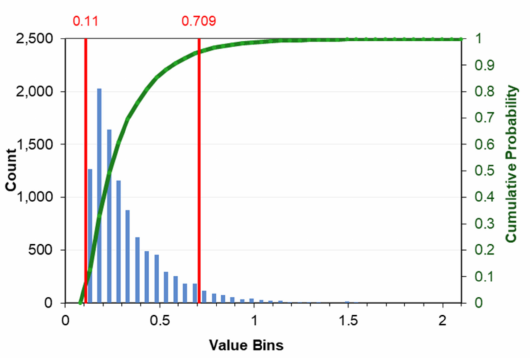
Figure 15. Histogram of Simple Payback Period through MCS on Overhead